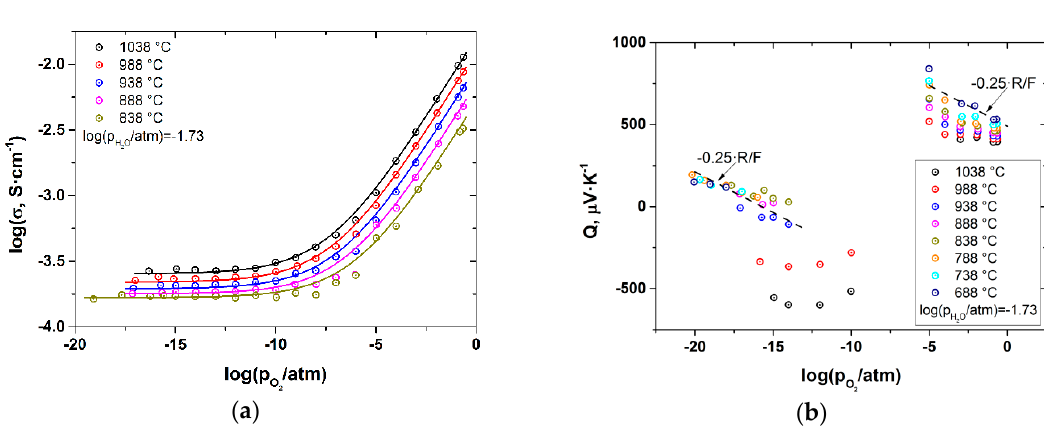
Figure 2. Total conductivity ( a ) and Seebeck coefficient ( b ) of BZY10 measured at log( p H 2 O/atm) = – = –1.73 as a function of T and p O 1.73 as a function of T and p O 2 . Points-experimental results, solid lines-calculation according to 2 . Points-experimental results, solid lines-calculation according to Equation (4) with parameters given in Table 1. Equation (4) with parameters given in Table Table 1. Fitted parameters of Equation (4)